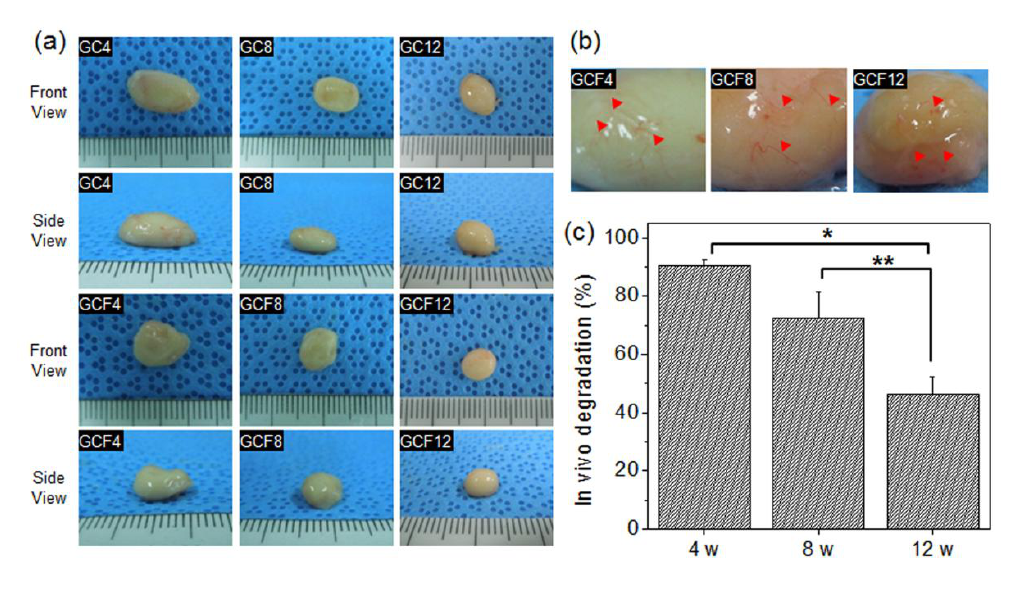
Figure 5. ( a ) Images of the removed MCL without (GC) or with (GCF) osteogenic factors, after 4, 8, and 12 weeks. The numbers indicate the implantation time; ( b ) enlarged images of the removed MCL hydrogels (GCF) and ( c ) volume change in the in vivo excised MCL hydrogels (GCF) after 4, 8, and 12 weeks (* p < 0.001, ** p <